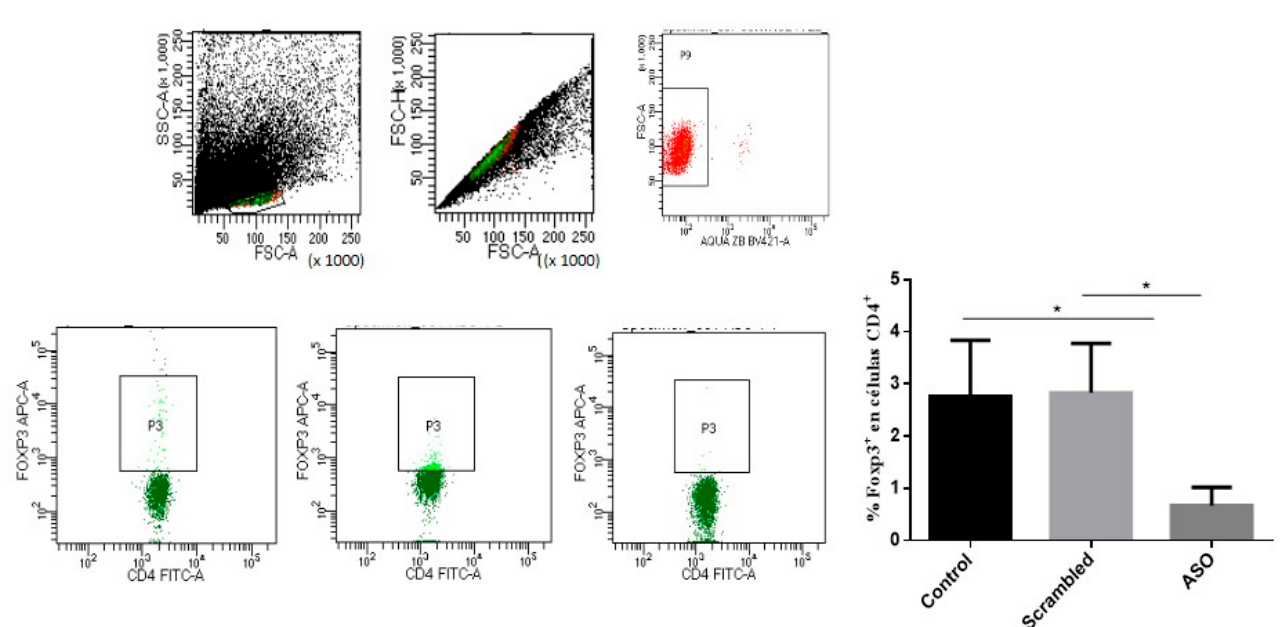
Figure 3. Biological activity of the anti-Foxp3 antisense oligonucleotide (ASO). Effect of anti-Foxp3 ASO in mouse spleno- cytes on CD4 + Foxp3 + cell populations. The upper panel represents the strategy of gates and the confirmation of the viability of the cells studied. The lower panel shows representative images of the reduction of CD4+ Foxp3+ population (as %) in the cells treated with anti Foxp3 ASO. A one-way analysis of variance (ANOVA) with Tukey’s post-hoc test was used. The confidence interval was established at 95% for all tests. The level of significance and p -values are shown as * ( p < 0.05).